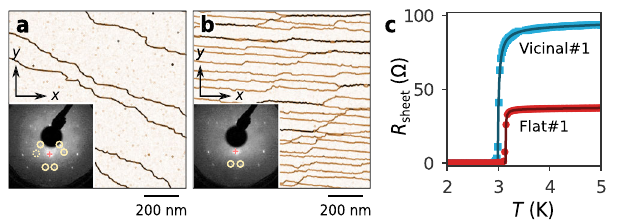
Fig. 4 Characterisation of samples for electron transport measurements. a , b STM images of Flat#1 and Vicinal#1, respectively. The derivative (gradient) of the topographic data is displayed for highlighting the locations of atomic steps. The insets are the corresponding LEED patterns taken at a 94 eV beam energy. The circles indicate the peaks re fl ecting the periodicity. The plus symbol indicates (0, 0). c Resistance curves of Flat#1 and Vicinal#1 measured at zero magnetic fi eld. The solid curves are fi tting by an empirical formula (See Supplementary Note